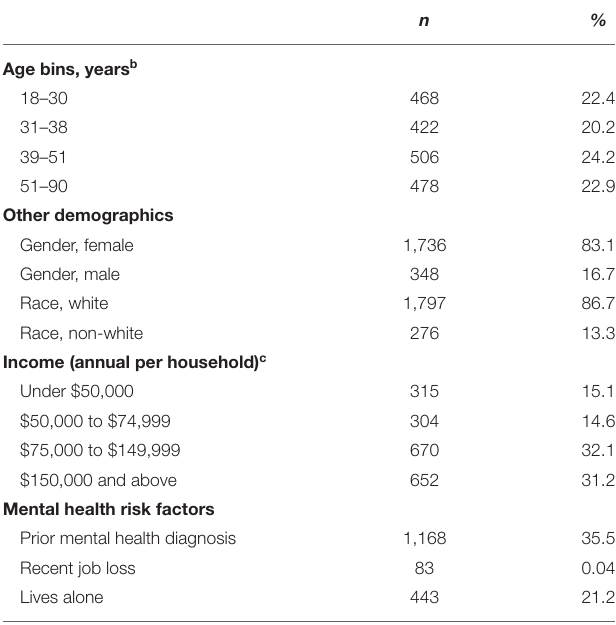
TABLE 1 | Cohort demographics a ( N =